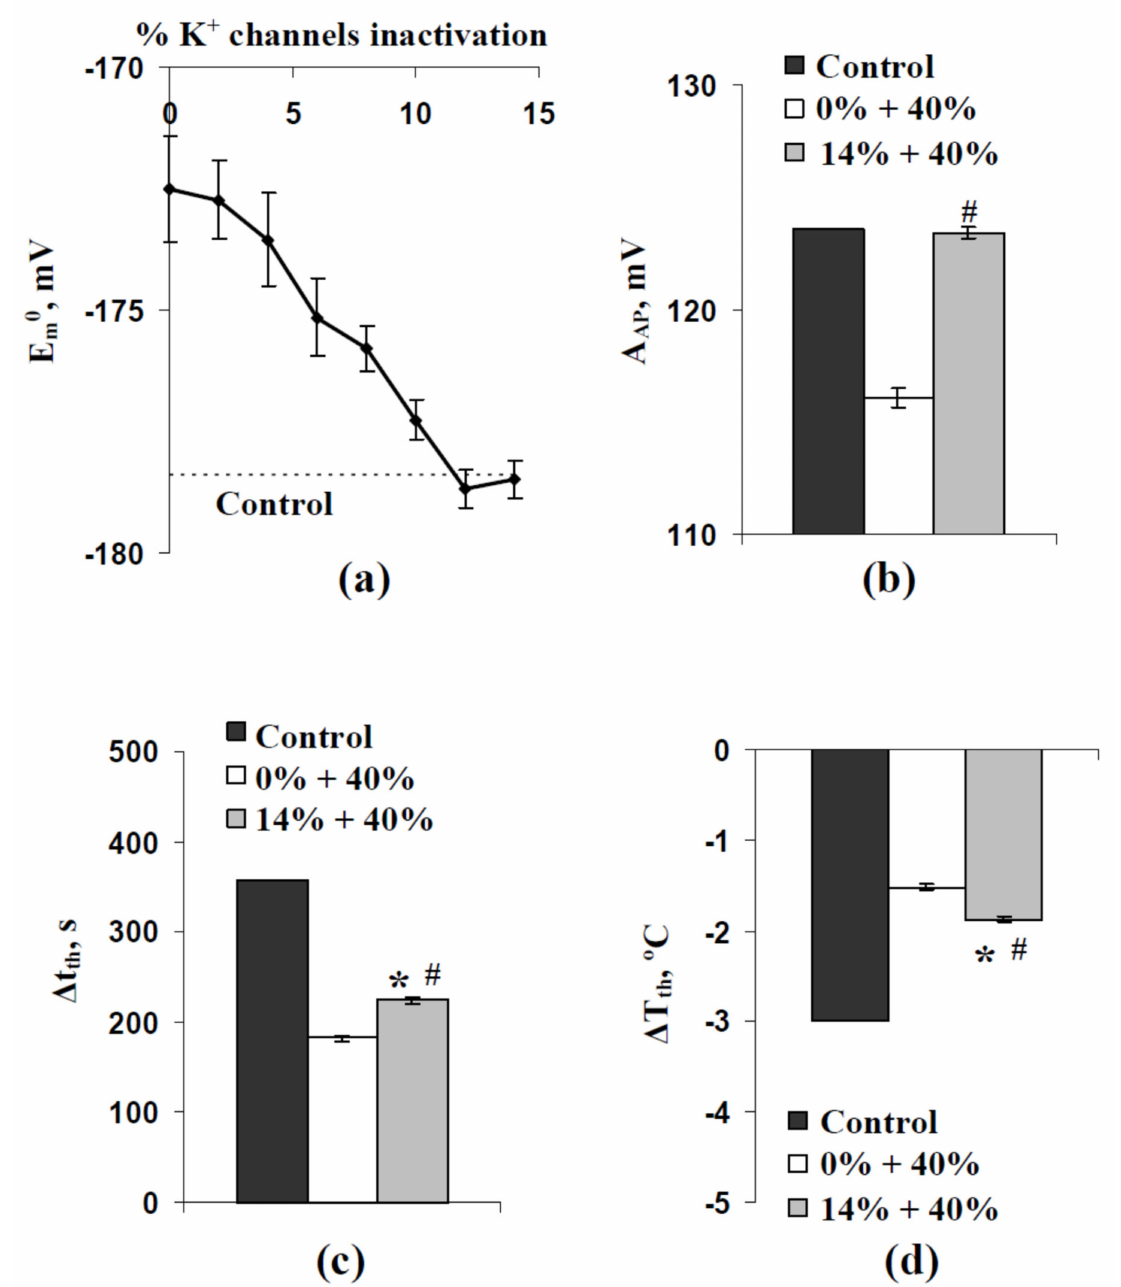
Figure 8. ( a ) Dependences of E m0 on percentage of inactivation of inward K + channels at SD = 40% ( n = 5) and ( b ) A AP , ( c ) ∆ t ∆ T + channels, SD = 0%), the “0% + 40%” variant (no inactivation of K + th , and ( d ) th in the control (no inactivation of K channels, SD = 40%), and the “14% + 40%” variant (14% of K + channels inactivation; SD = 40%). *, the “14% + 40%” variant was significantly differed from the control. #, the “14% + 40%” variant was significantly differed from the “0% + 40%” variant. The rate of the T decrease was 0.5 ◦ C min − 1 . Averaged parameters (A AP , ∆ t th , and ∆ T th ) shown in Figure 8b–d were calculated on the basis of 25 repeated